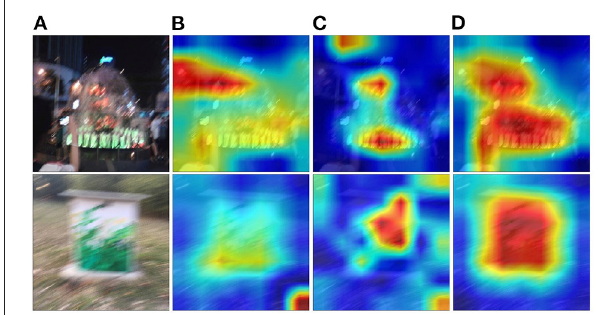
intelligibility features may have already existed in the